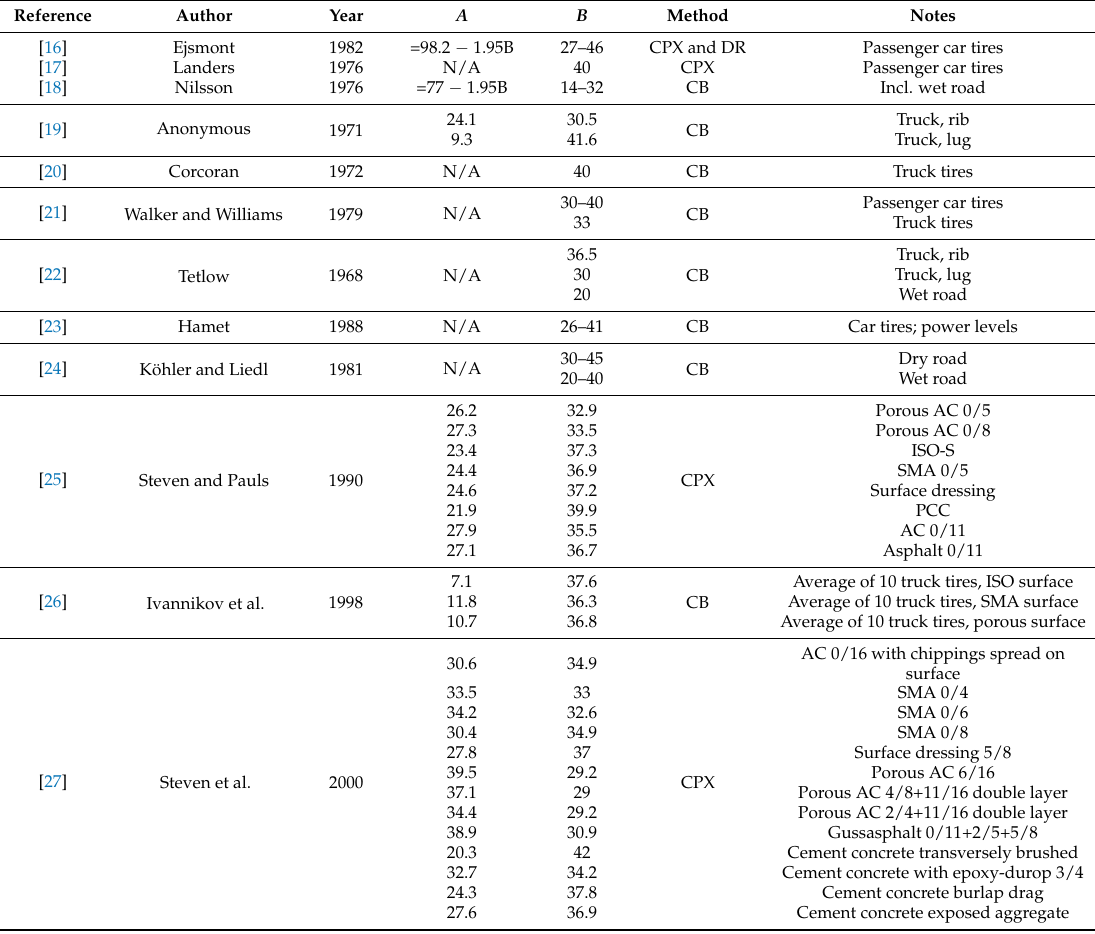
Table 3. Coefficients in relationship between speed and TPIN level (source from Sandberg and